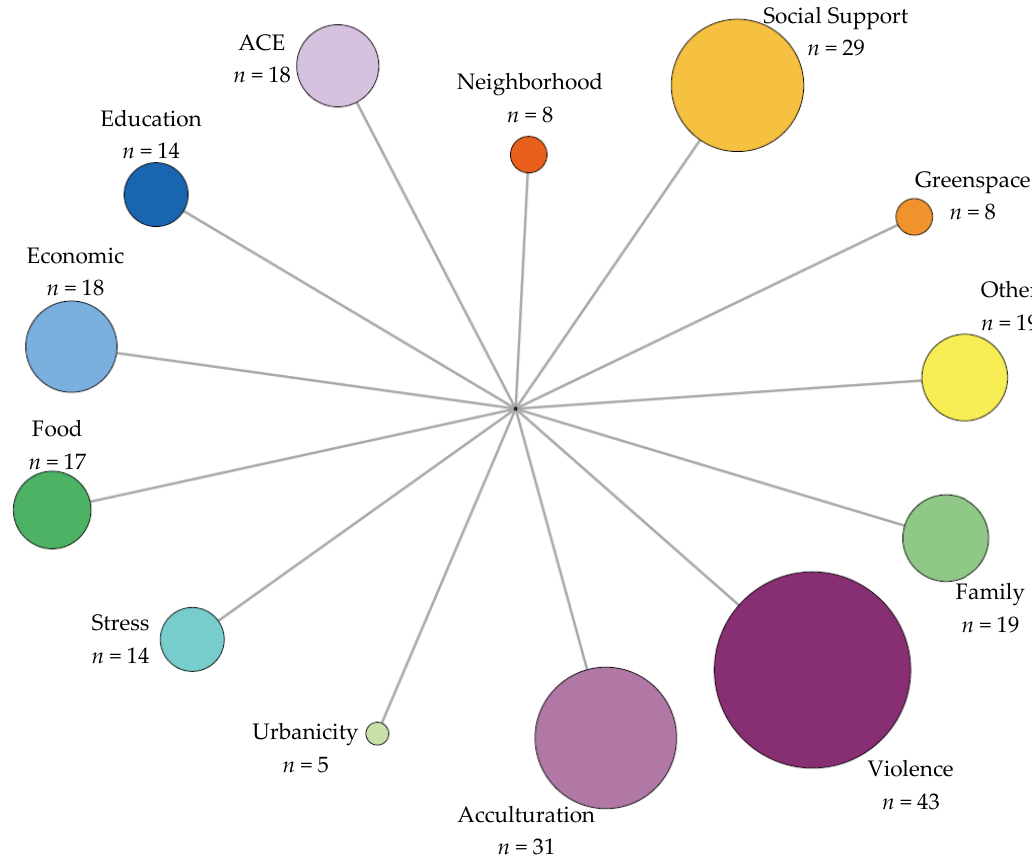
Figure 2. Non-chemical stressor general topic categories by frequency. -Size of circle represents frequency of times topic is investigated.